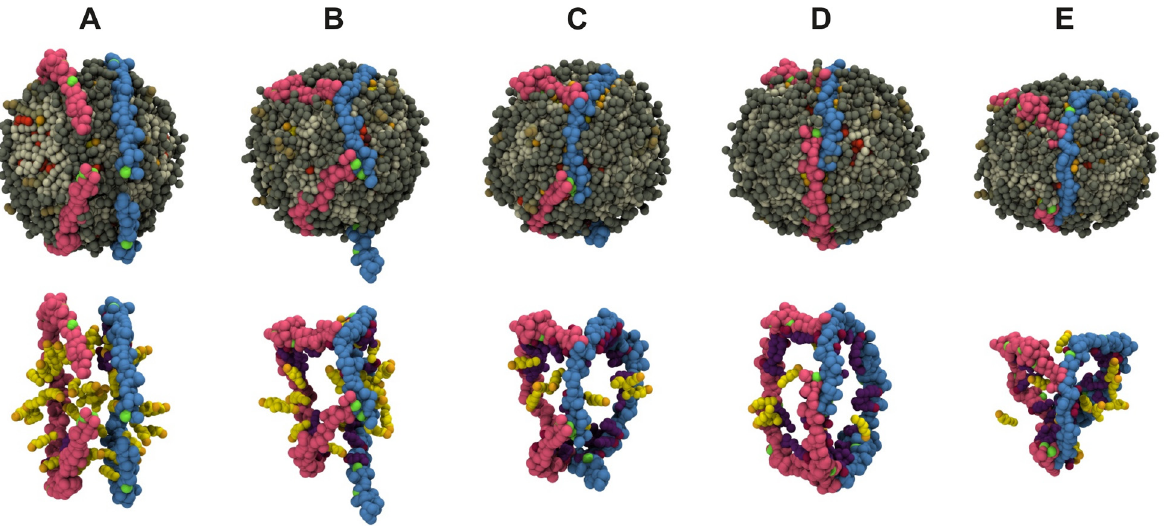
Figure 10. Illustrative snapshots of HDL structure. (Top) Different snapshots of the full HDL simulation: (A) 0 m s, (B) 0.4 m s, (C) 1.4 m s, (D) 12.4 m s, and (E) 19.04 m s. (Bottom) Snapshots displayed at the top of the figure showing here only the apoA-I molecules, and annular and bulk CHOL molecules. The two apoA-I chains are in light red (chain A) and light blue (chain B) with proline residues in green. Annular CHOL molecules are shown in purple with a dark red hydroxyl group. Bulk CHOL molecules are depicted in yellow with an orange hydroxyl